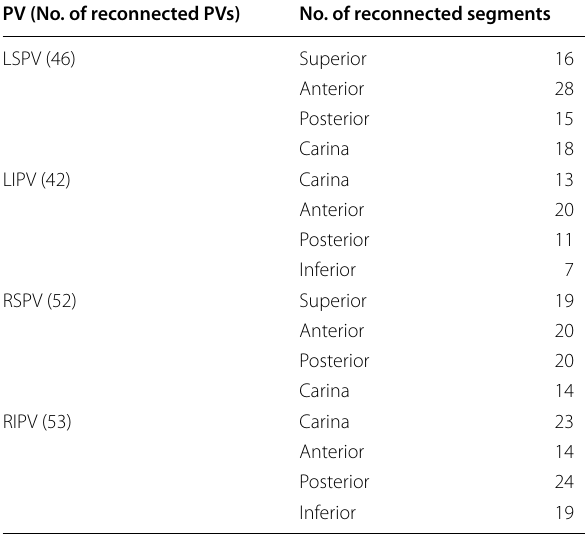
Table 2 Reconnected pulmonary veins and their segments in 79 patients